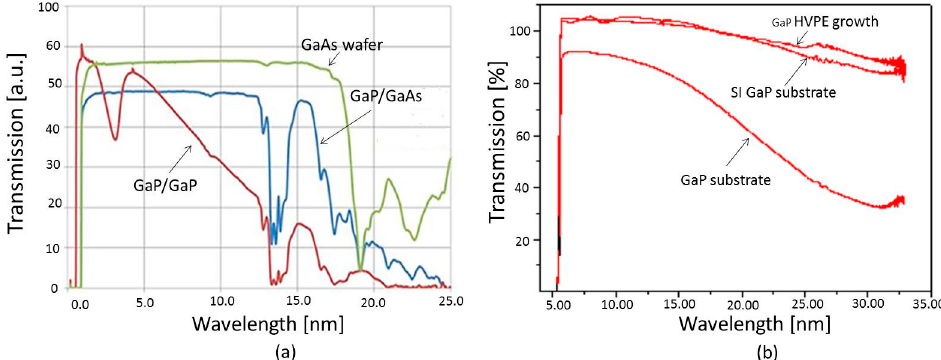
Figure 10. ( a ) The additional absorption band between 2–4 µm in GaP substrates (red line) does not exist in GaAs (green line) and is reduced in the Halide Vapor Phase Epitaxy (HVPE) heteroepitaxially grown GaP deposited on GaAs; ( b ) the HVPE grown material is as transparent in the IR as the commercial p-doped SI GaP [59]. (Reproduced from [59] with the permission of OSA).